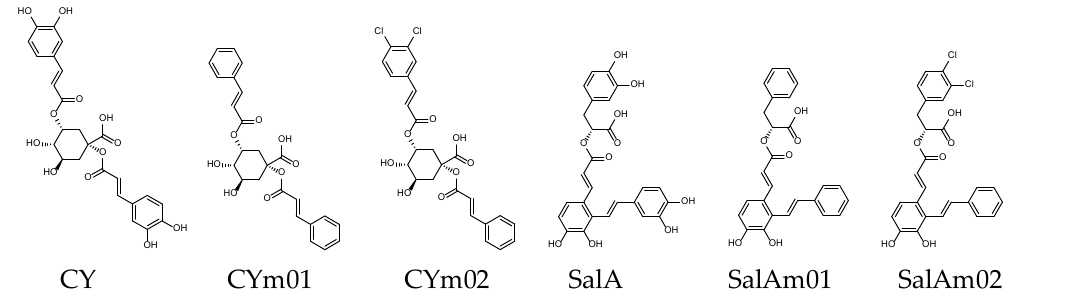
Figure 8. Structures of RosA derivatives. Chlorogenic acid (CCA) is for reference and comparison.